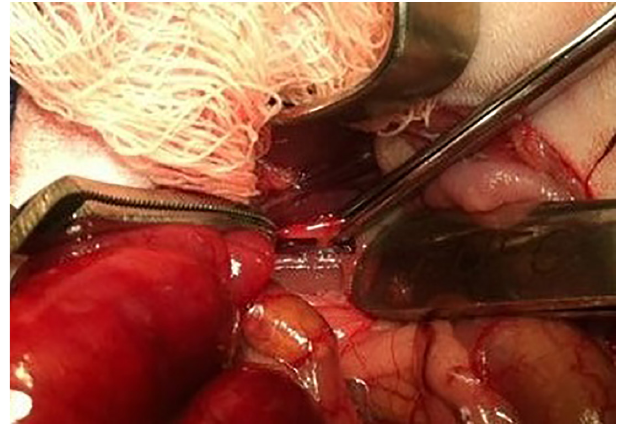
Fig. 1 - Proximal and distal clamping of the aorta with Bulldog De Bakey and hemostasis with